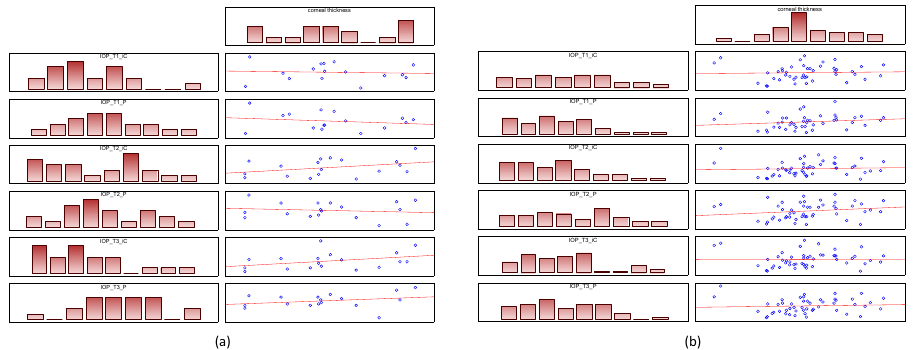
Figure 5. Correlation of CCT and IOP for iCare and Perkins ( a ) glaucoma subjects ( b ) healthy children. Abbreviation: CCT: corneal thickness; IOP: intraocular pressure; IC: iCare; P: Perkins.